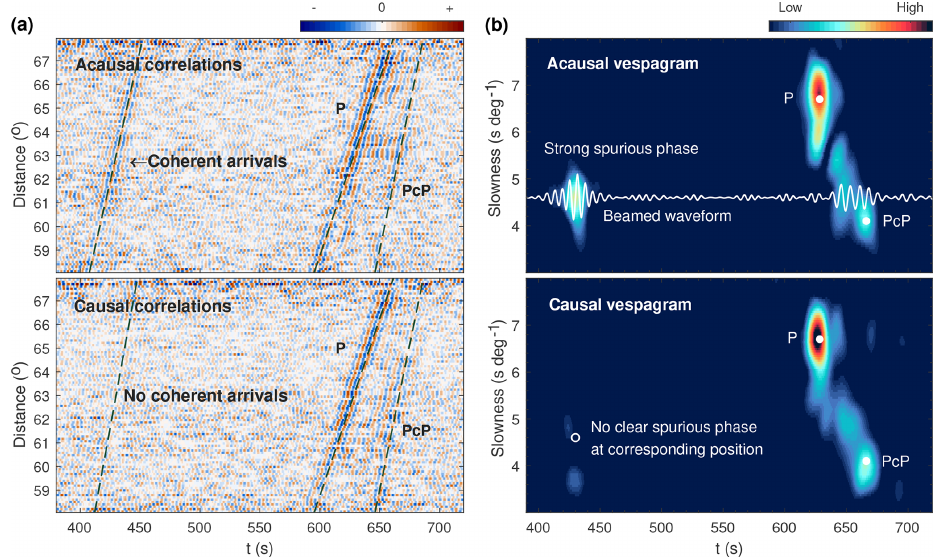
Figure 4. (a) Waveform sections and (b) vespagrams of the acausal and causal parts of the vertical–vertical noise correlations filtered in the period band from 5 to 10s. The acausal section for negative time lags is flipped to share a common time axis with the causal